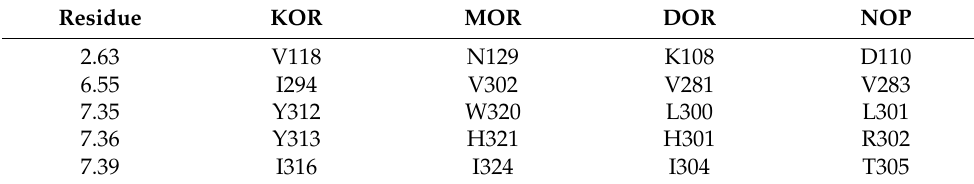
Table 3. Non-conserved residues within the opioid receptor family participating in SalA binding.